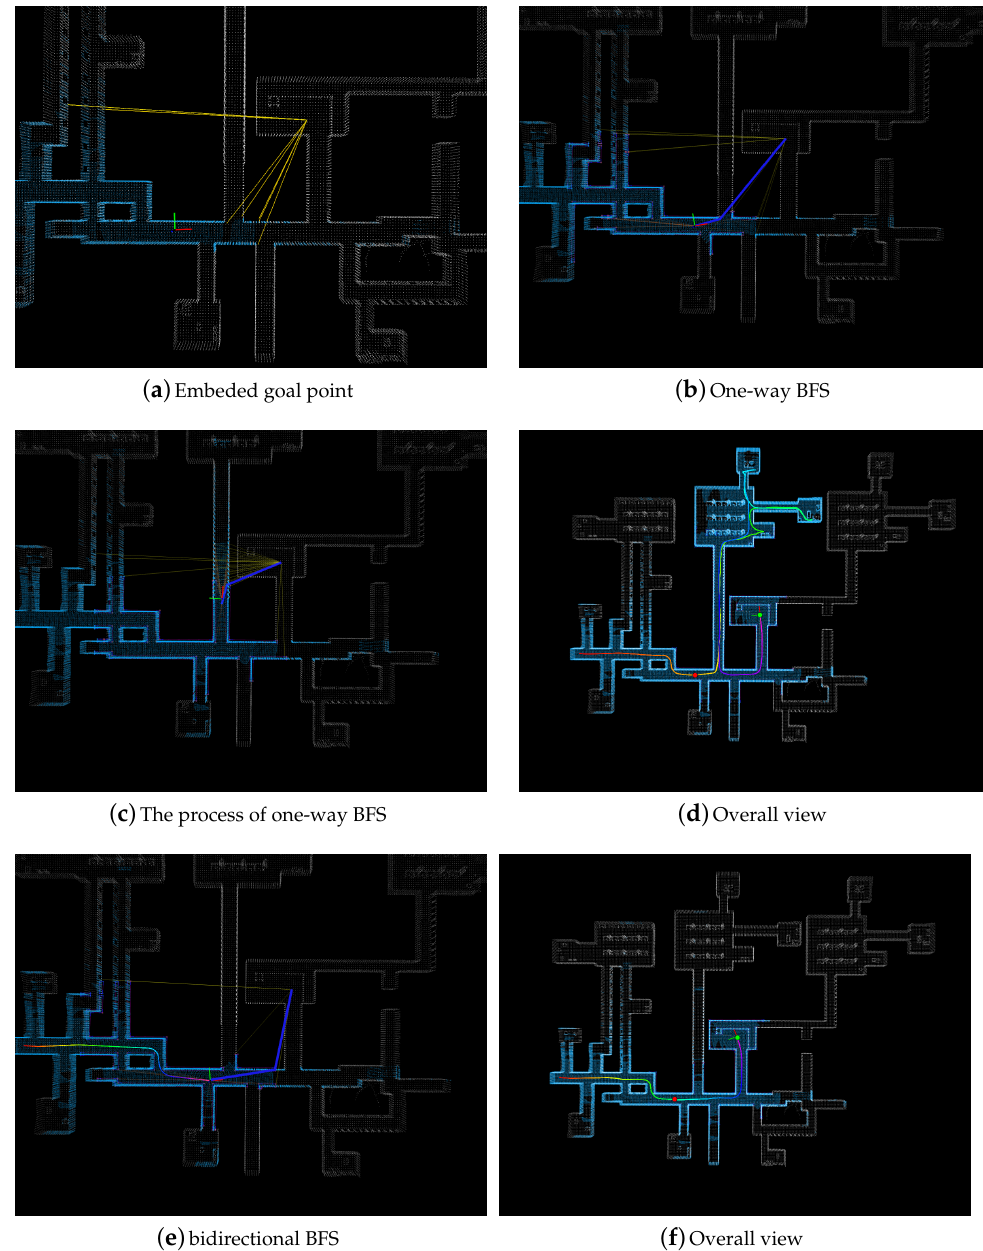
Figure 13. The blue area of the map represents the part that has been explored by LiDAR and is considered known. ( a ) shows the connection between the endpoint and the existing node, represented by a solid yellow line. ( b , c ) show the path planning using one-way BFS. ( d ) is the result of one-way BFS. The red dot is the starting point, and the green dot is the endpoint. ( e , f ), respectively, show the path planning and the final result using bidirectional BFS. The globally planned path appears on the map as a thick blue